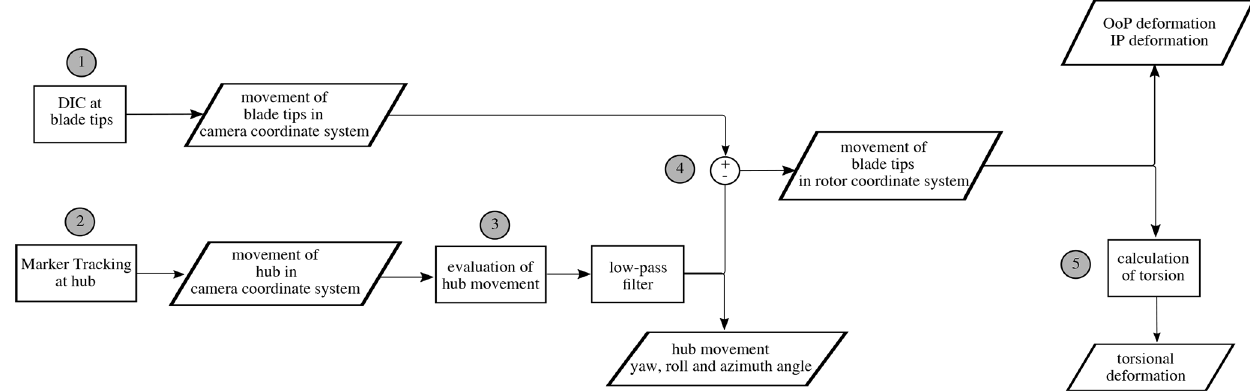
Figure 9. Evaluation of DIC and point-tracking method for determination of rotor blade deformation and torsion.